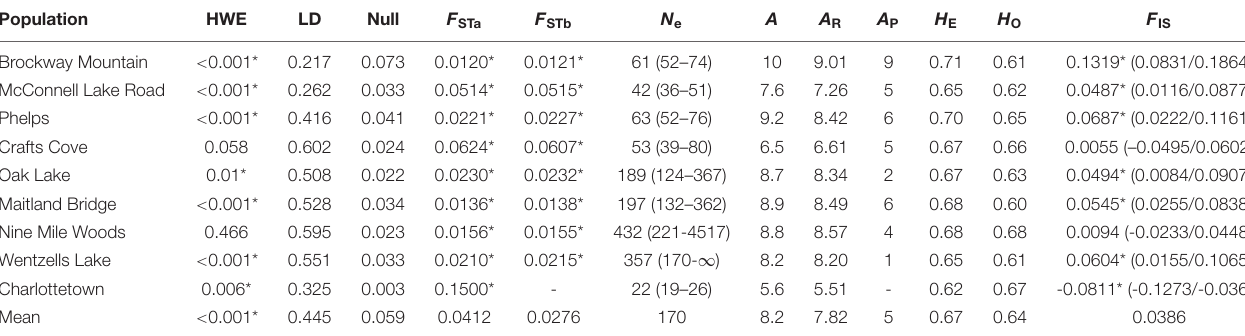
TABLE 2 | Hardy-Weinberg equilibrium test (HWE, Fisher’s exact test), p -values mean values of linkage disequilibrium (LD) test between all pairwise loci comparisons, mean estimates of null allele frequencies (Null), population-specific F ST value, contemporary ( N e ) effective population size and its 95% confidence intervals, average number of alleles per locus ( A ), allelic richness ( A R ), number of private alleles ( A P ), expected ( H E ) and observed ( H O ) heterozygosity (standard error in brackets), and fixation index ( F IS –95% confidence intervals in brackets) of nine northern red oak